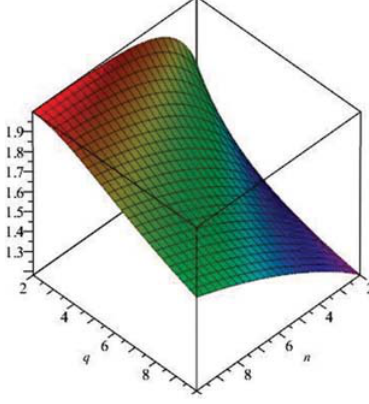
Figure 4: Plot of ξ c